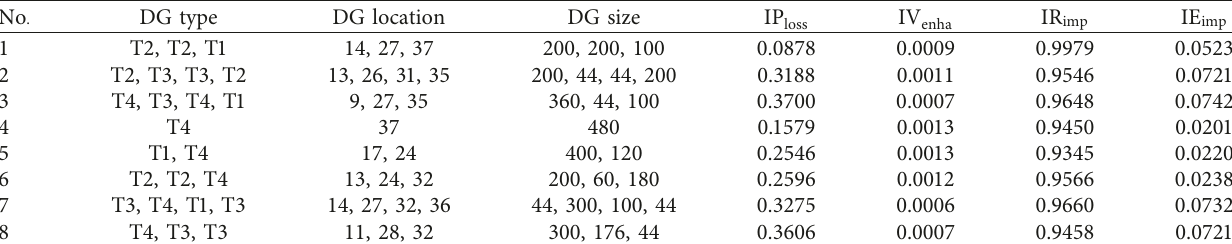
Table 5: The objective function values for some Pareto front